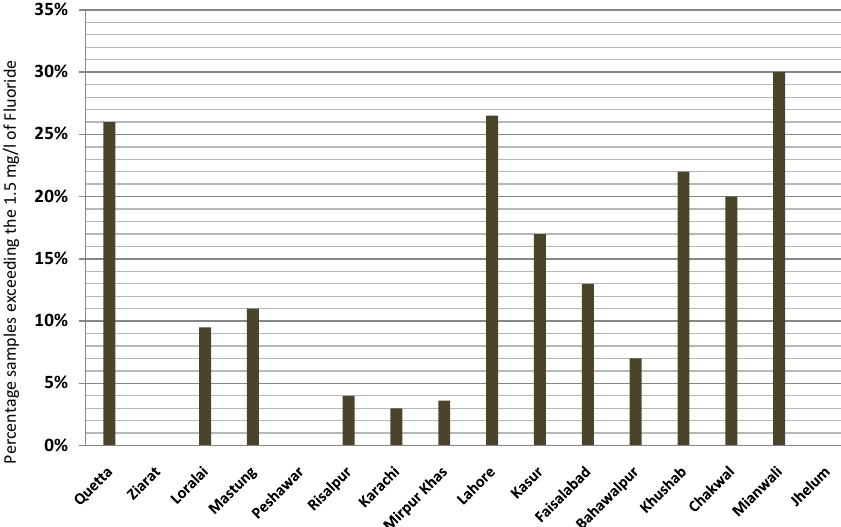
Figure 1. Distribution of fluoride in 16 cities of four provinces.